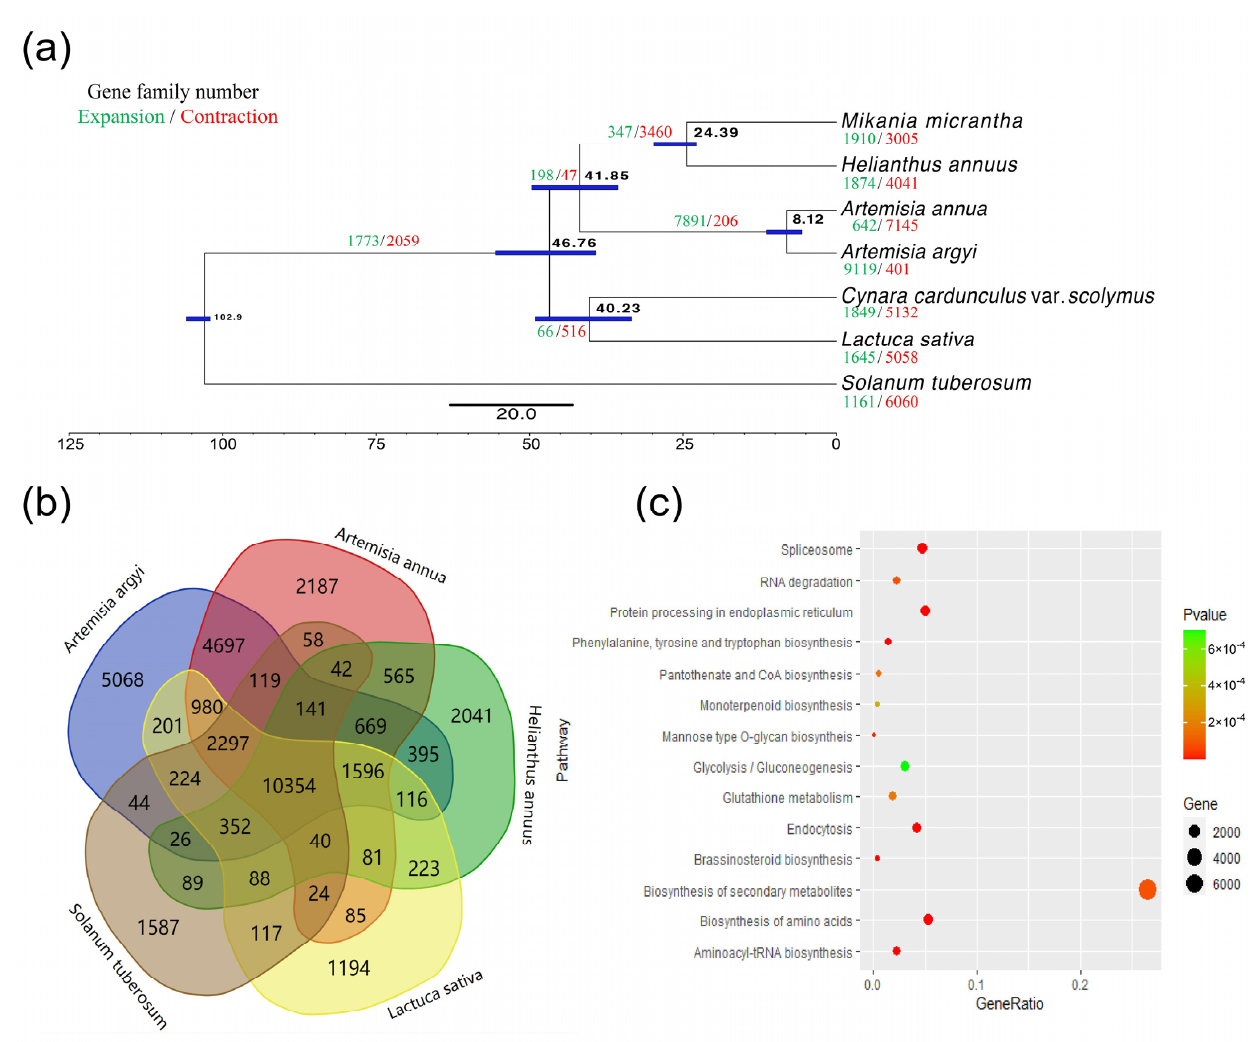
Figure 2. Evolutionary analysis of A. argyi genome. ( a ) Phylogenetic tree of Asteraceae species. Branch and taxa labels are numbers of gene families manifesting expansion (green) and contraction (red). Node labels are divergence times estimated by maximum likelihood (ML) algorithm. ( b ) Overlap of gene families of four Asteraceae specie and Solanum . ( c ) KEGG enrichment analysis of expansion gene families in the A. argyi genome.